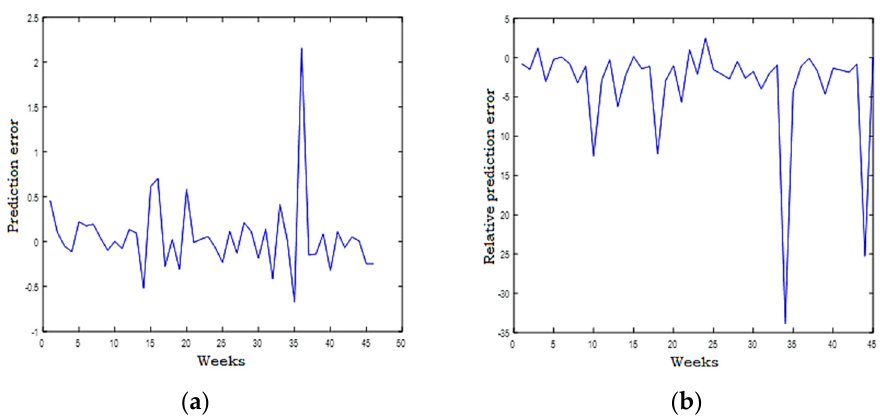
Figure 26. ( a ) Error and ( b ) relative error of the prediction of solar radiation using ARMA (2,1). MAE, MSE, and RMSE are shown in Table 12. MSE has the lowest value, equal to